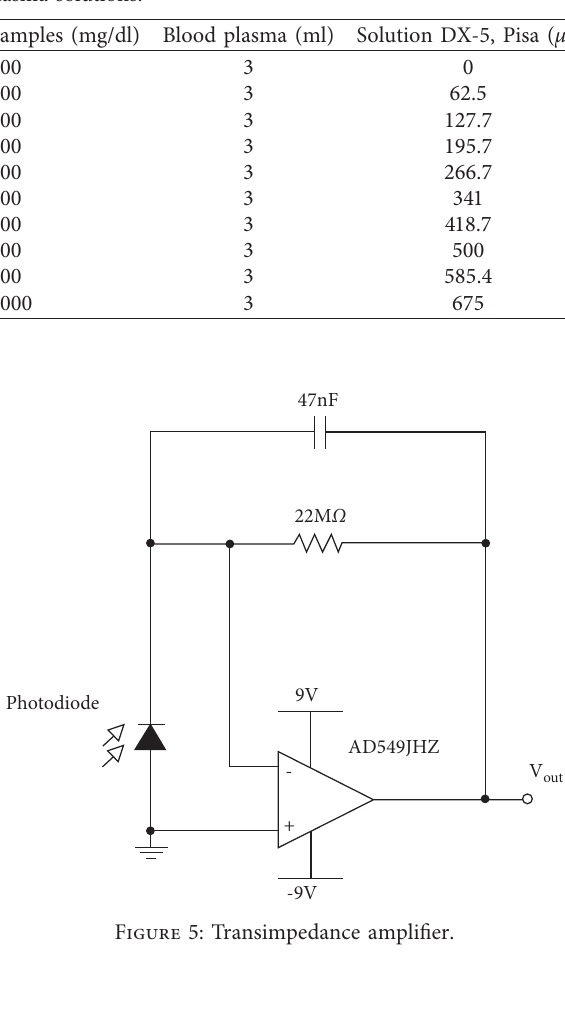
Table 2: Concentrations used for preparing samples of blood plasma solutions.